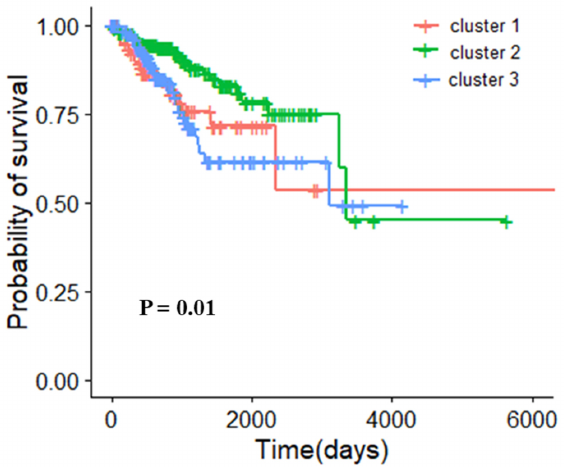
Figure 6. Survival analysis of di ff erent types of uterine corpus endometrial carcinoma samples after clustering (K = 3).